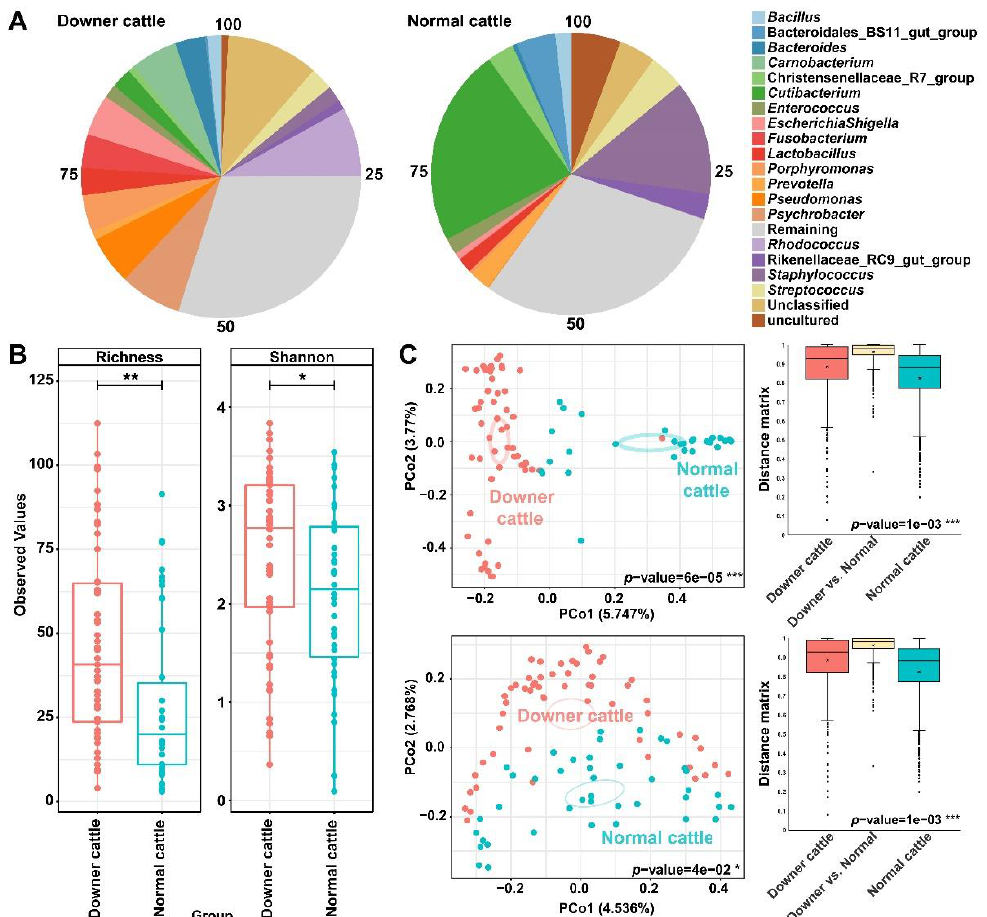
Figure 1. Relative abundance and microbial diversity of brain microbiota from downer and normal cattle. ( A ) Pie chart of relative abundance from downer and normal cattle’s microbiota at the genus level. ( B ) Alpha diversity indices (Shannon and Richness index) of downer and normal cattle groups based on the number of genera. ( C ) PCoA plot of beta diversity based on the Bray – Curtis (top) and Unweighted Unifrac (bottom) distance method and its distance matrix. Asterisks such as *, **, and *** mean p -values of 0.05, 0.01, and 0.001, respectively.